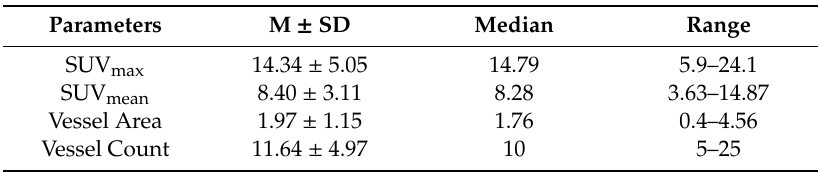
Table 2. Estimated 18 F-FDG-PET and microvessel density (MVD) parameters of head and neck squamous cell carcinoma